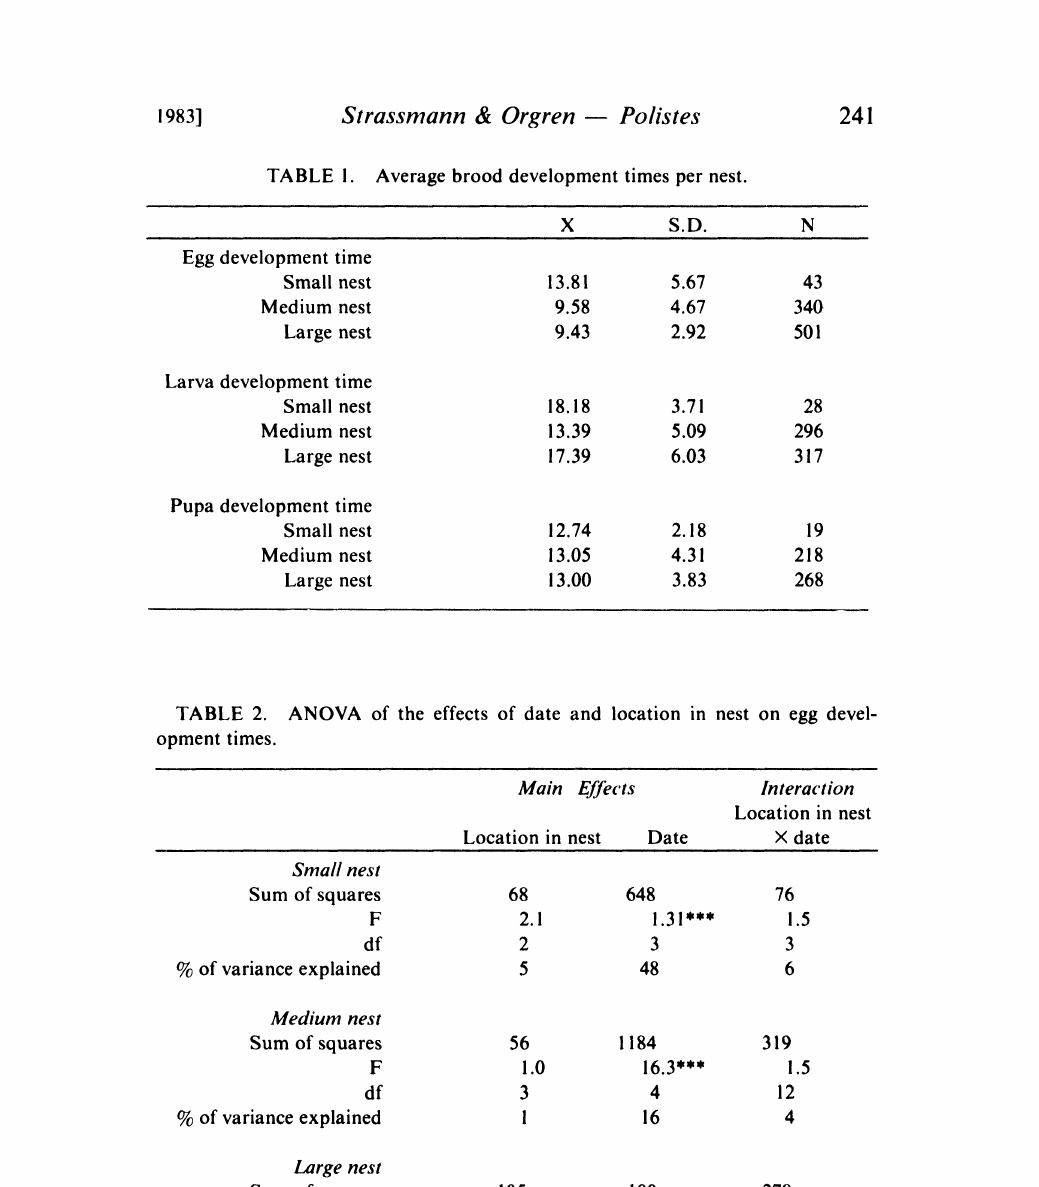
TABLE 2. ANOVA of the effects of date and location in nest on egg devel- opment